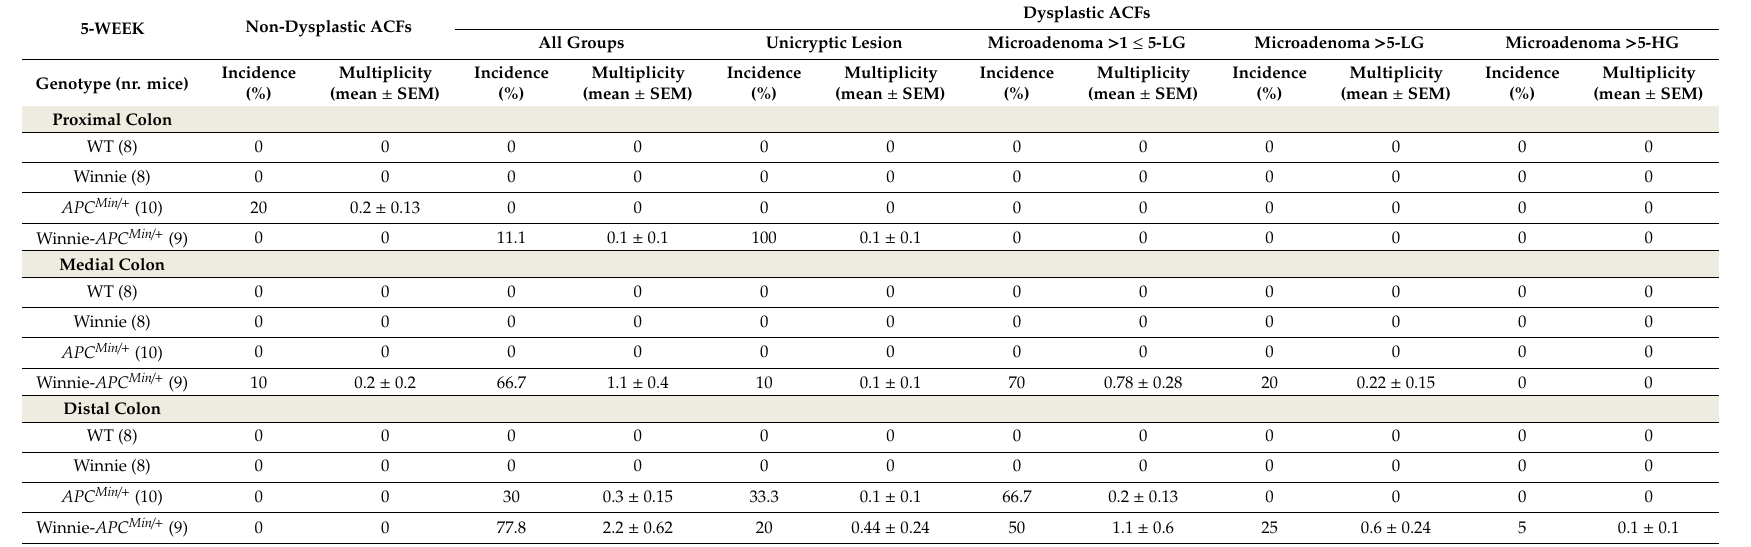
Table 1. Histological analysis of 5-week-old Winnie- APC Min /+ mice and control littermates. Incidence and multiplicity ± SEM of proximal, medial and distal colon were calculated for non-dysplastic and dysplastic aberrant crypt foci (ACFs). The score for dysplastic ACFs was calculated relative to all groups and to each group of neoplastic lesions classified according to dimension and grading of unicryptic lesions; microadenoma > 1 ≤ 5 crypts low-grade (LG); microadenoma > 5 crypts low-grade (LG) and microadenoma > 5 crypts high-grade